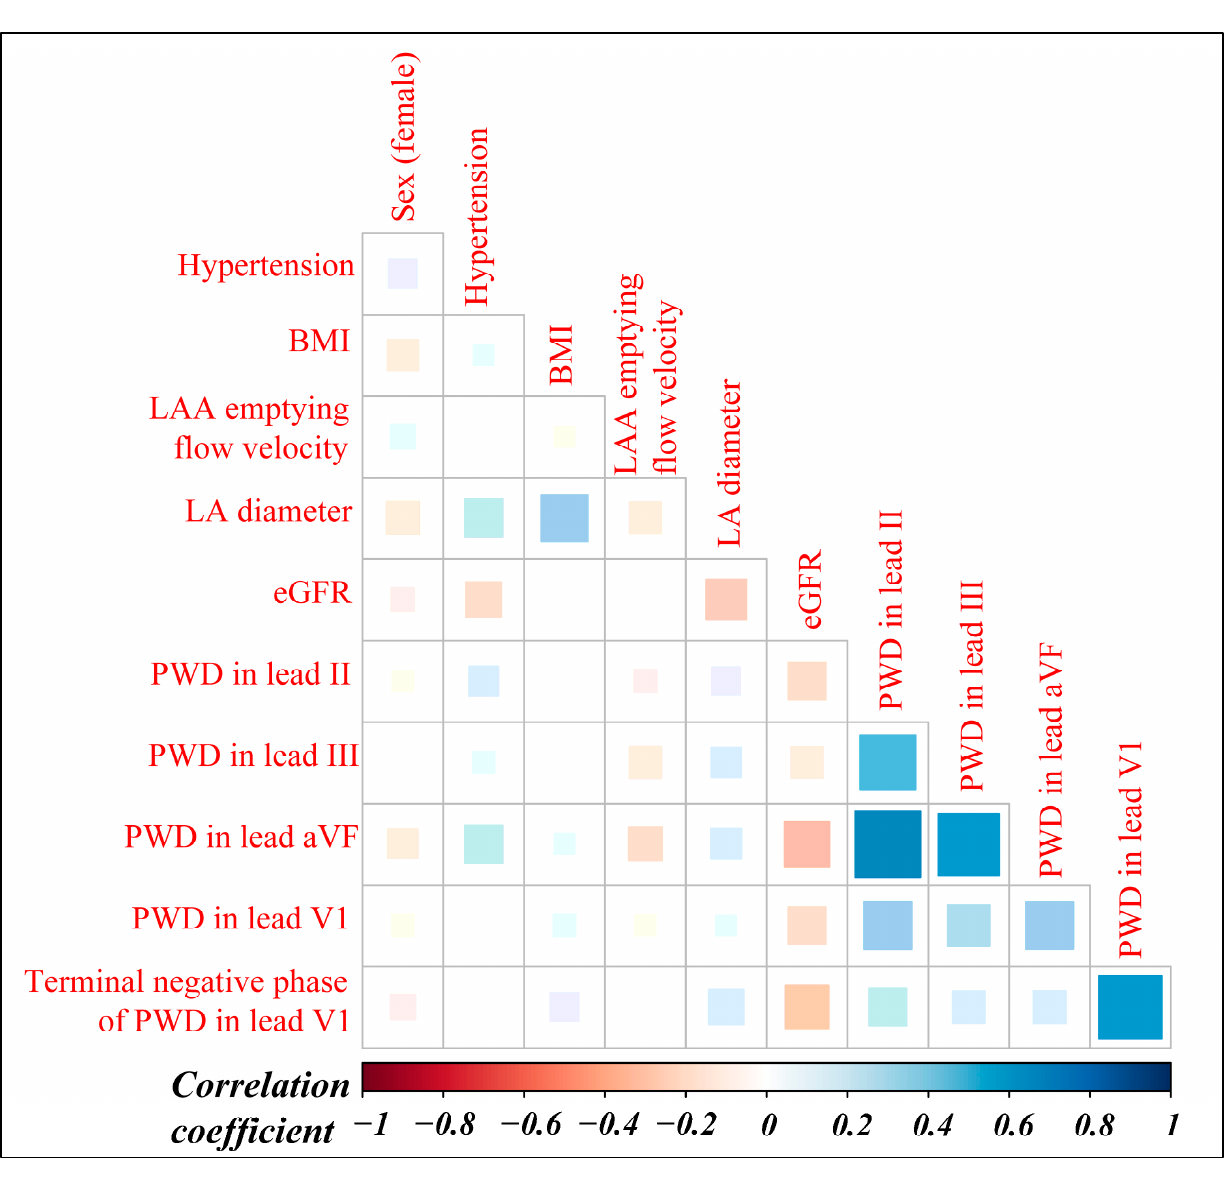
Figure 2. Correlogram of the candidate predictors.